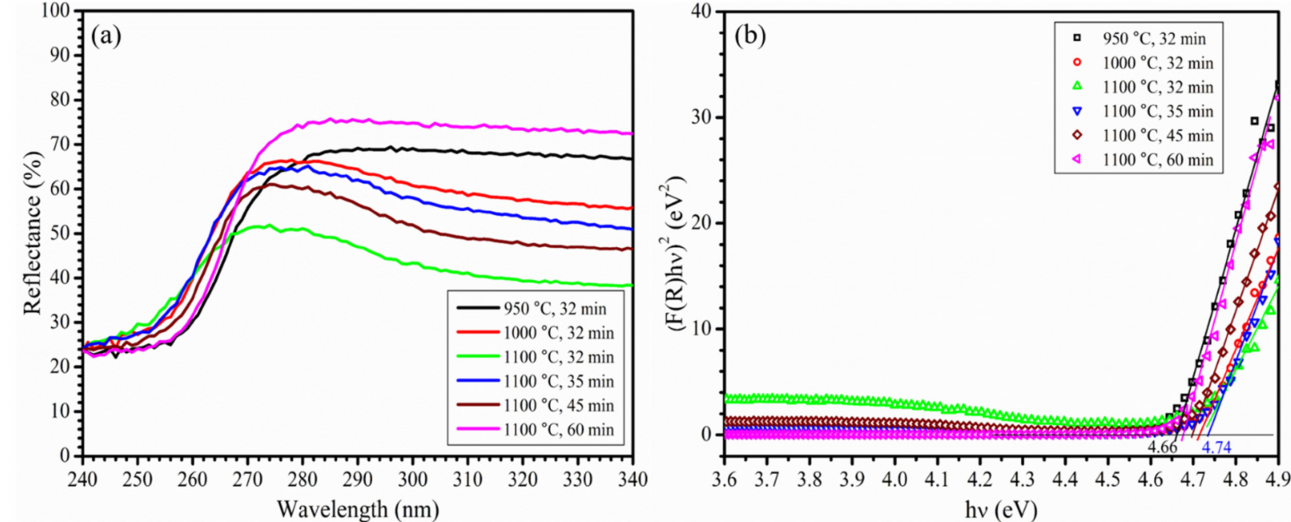
Figure 6. ( a ) Diffuse reflectance spectra, and ( b ) a plot of ( F ( R ) · h ν ) 2 as a function of photon energy for the determination of bandgap of as-grown β -Ga 2 O 3 nanostructures prepared at 950 ◦ C and 32 min (black), 1000 ◦ C and 32 min (red), 1100 ◦ C and 32 min (green), 1100 ◦ C and 35 min (blue), 1100 ◦ C and 45 min (wine), and 1100 ◦ C and 60 min